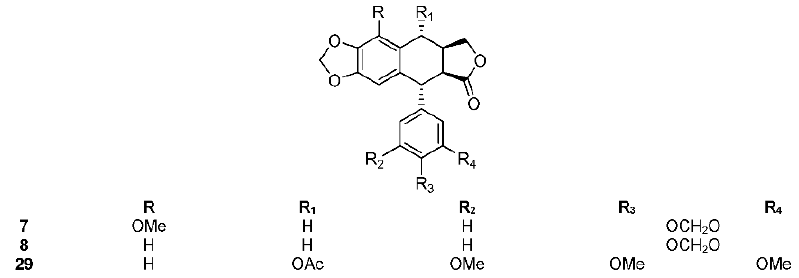
Figure 2. Aryltetraline lignans ( picro series) isolated from Bursera spp.